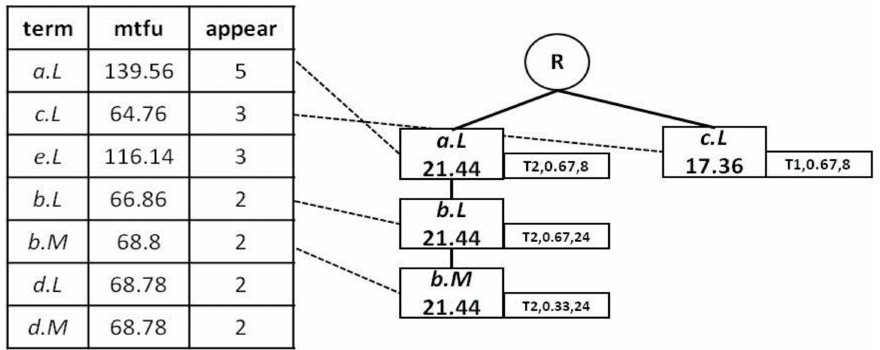
Figure 3. Inserting T 2 into the tree.